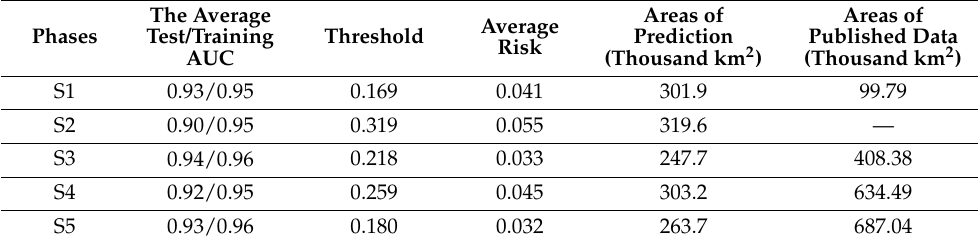
Table 2. Predicted results at different times over